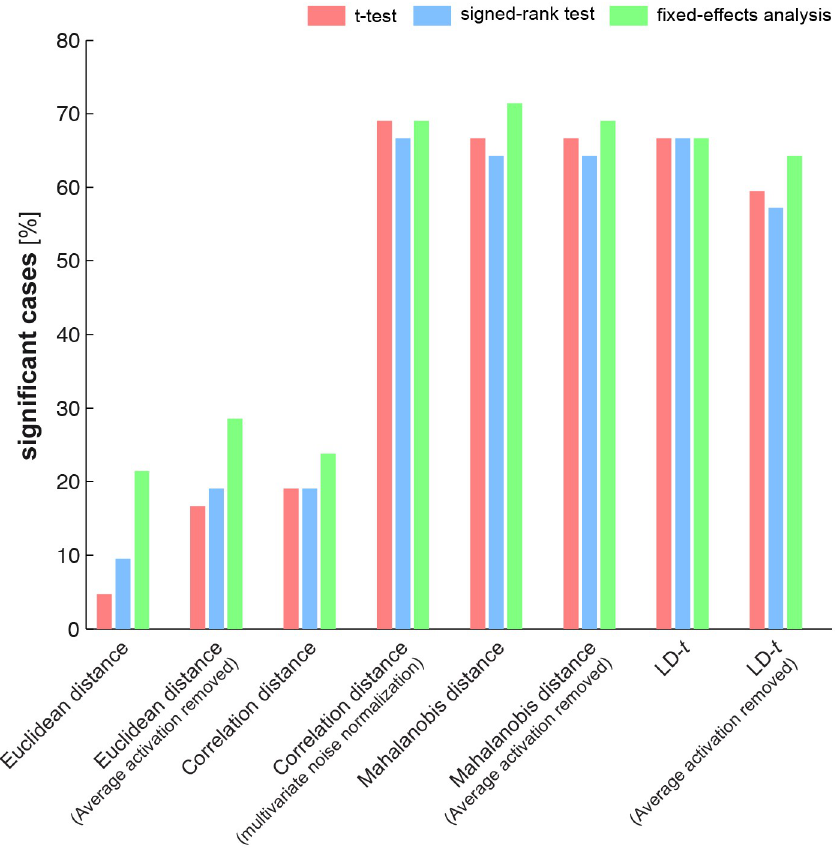
Fig 10. Comparing the sensitivity of different tests. Each test was applied to fMRI data from six different ROIs. In each ROI, discriminabilities of seven category subsets were assessed. A test was pronounced significant if p < 0.001. The height of the bars shows the percentage of significant cases out of the 42 tested scenarios (e.g. 50% corresponds to 21 significant tests). Tests on EDIs computed from multivariately noise-normalized response patterns were significantly more powerful (the last five triple of bars). Inference was done using subject bootstrap. All pairwise comparisons between the two groups of tests (i . e . the first three triple of bars and the next five triples of bars corresponding to unnormalized and multivariate noise-normalized data) were significant after controlling the expected false discovery rate at 0.01.